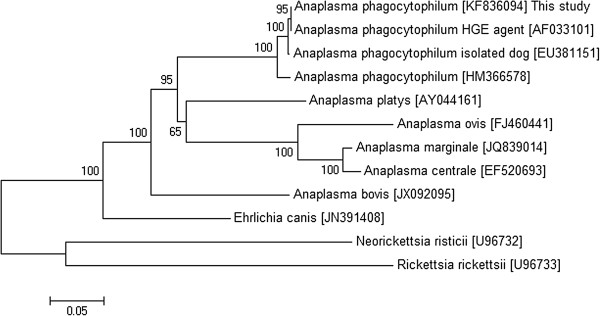
Phylogenetic dendrogram of Anaplasma phagocytophilum isolated from dogs and ticks based on groESL heat shock operon gene sequence comparison (1167 bp). GenBank accession numbers are shown in parentheses. The tree was constructed using the neighbor-joining method and numbers above internal nodes indicate the percents of 1,000 bootstrap replicates that supported the branch.